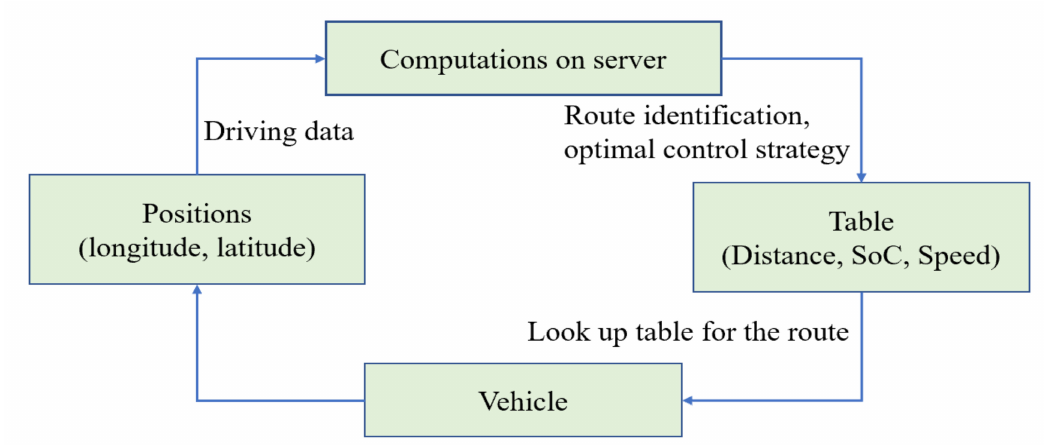
Figure 18. Schematic diagram of a route-optimized